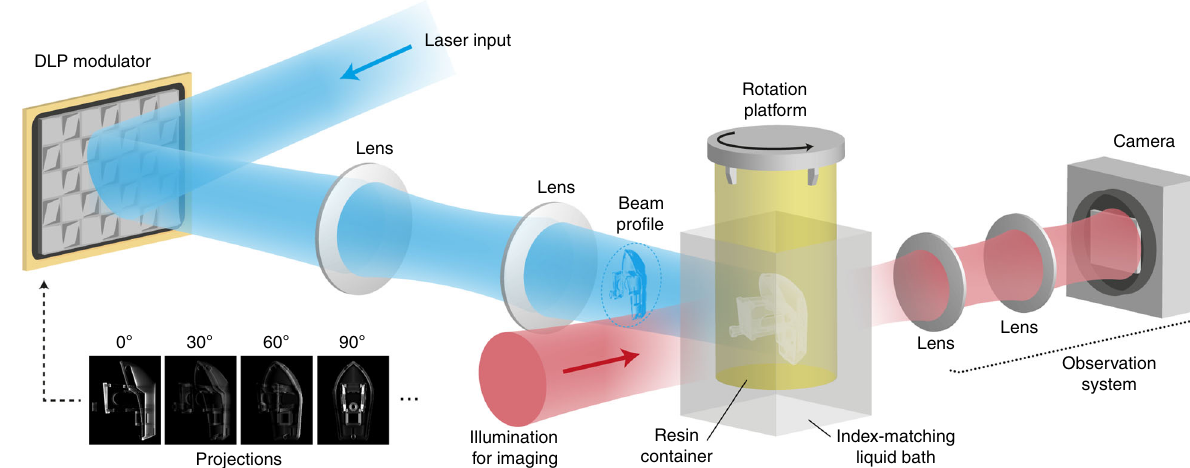
Fig. 1 Experimental setup for high-resolution tomographic printing.